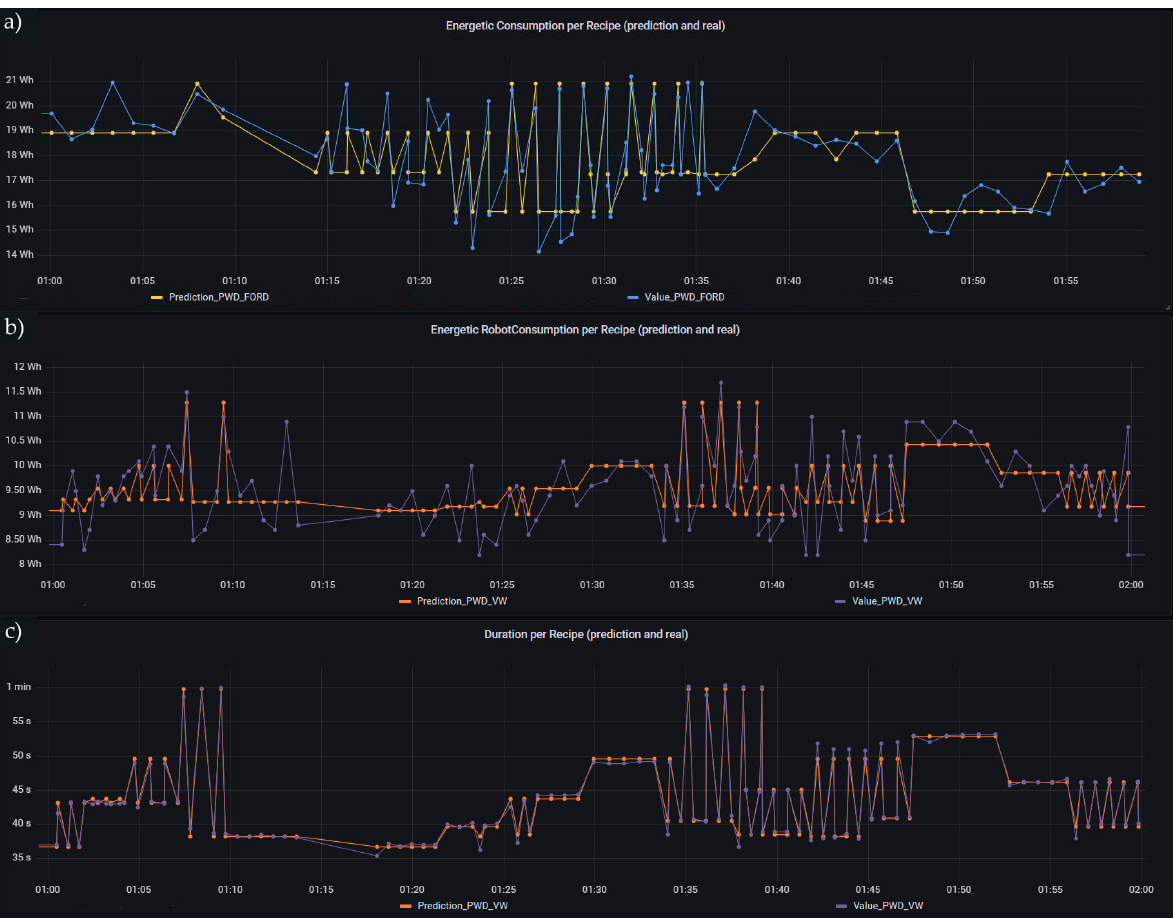
Figure 23. Predicted and real values per recipe of ( a ) cell energy consumption, ( b ) robot energy consumption and ( c ) duration.